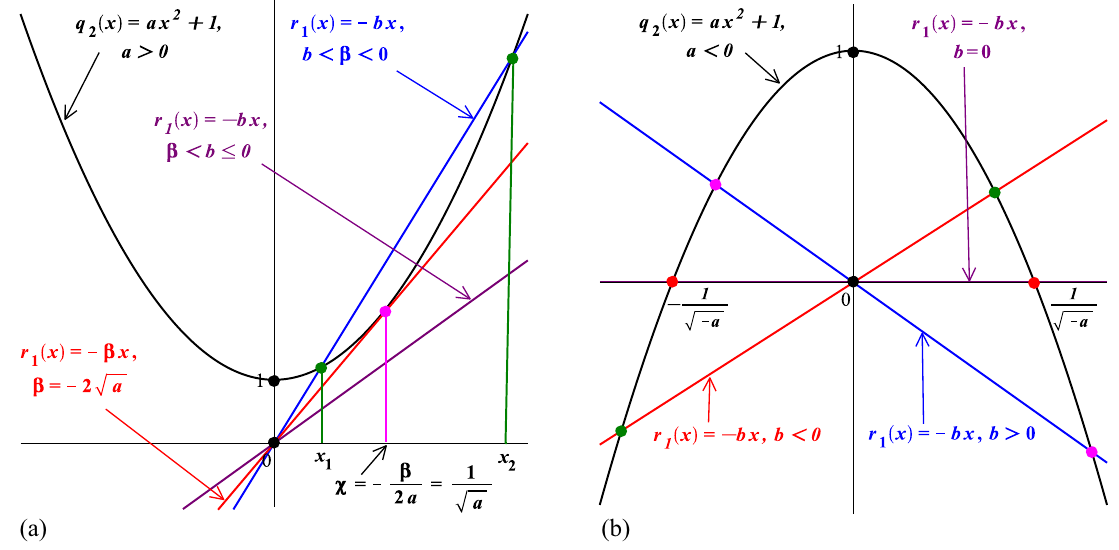
Figure 1: The quadratic equation ax bx 1 − 2 + = . ( a ) The case of a 0 > and b 0 ≤ . When a 0 > and b 0 ≥ , the situation is analogical to the one shown here as there is